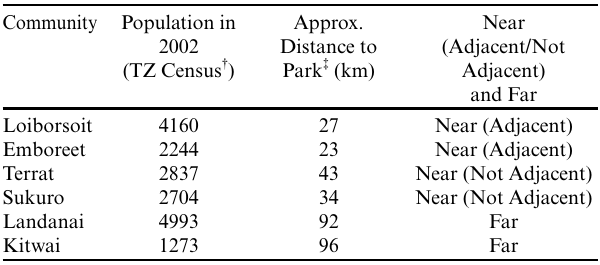
Table 1 . Study communities population and proximity